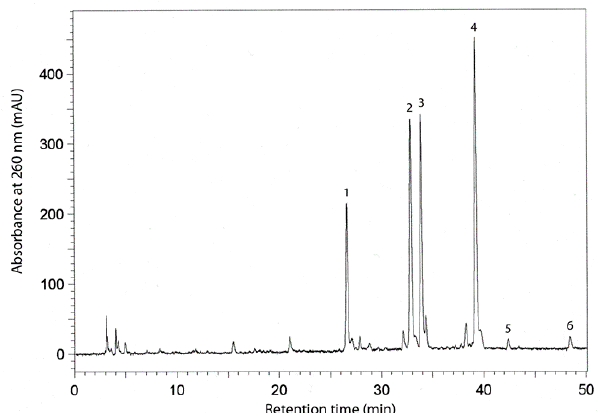
Figure 2. Chromatogram of resolved isoflavones in seed extracts of the soybean cultivar Aldana.